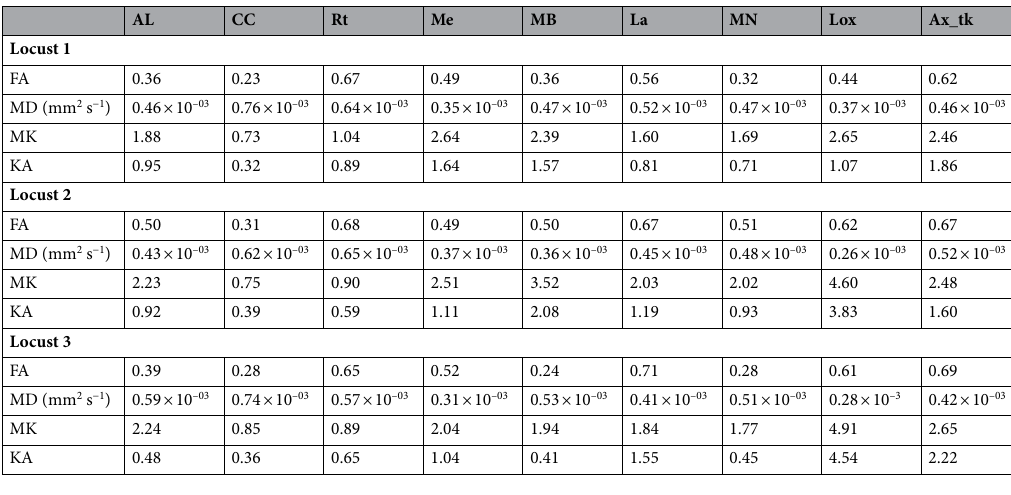
Table 1. Median values of Kurtosis tensor derived directionally invariant indices from selected ROIs. AL antennal lobe, CC central complex, Rt retina, Me medulla, MB mushroom body, La lamina, MN midbrain neuropil, Lox lobula complex, Ax-tk axonal